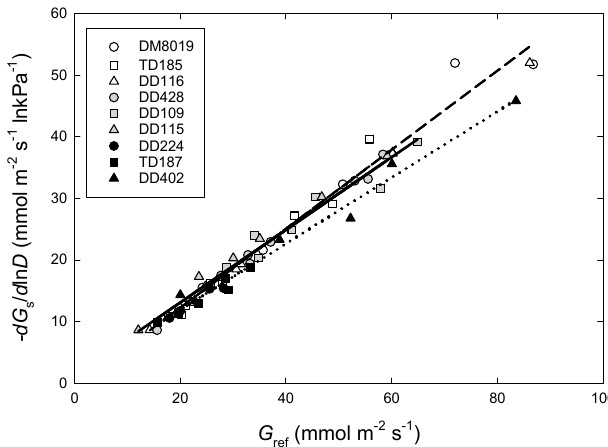
Figure 7. Relationship between the sensitivity of canopy stomatal conductance ( G s ) to vapor pressure deficit ( D ) (- dG s / d ln D ) and G s at D = 1 kPa ( G ref ) at high PAR (PAR > 800 µmol m − 2 s − 1 ) in P. deltoides (DD), P. trichocarpa × deltoides (TD), and P. deltoides × maximowiczii (DM) clones. Open symbols and dashed line, light shaded symbols and solid line, and dark shaded symbols and dotted line represent high (Group H), intermediate (Group I), and low (Group L) productivity genotypes, respectively.